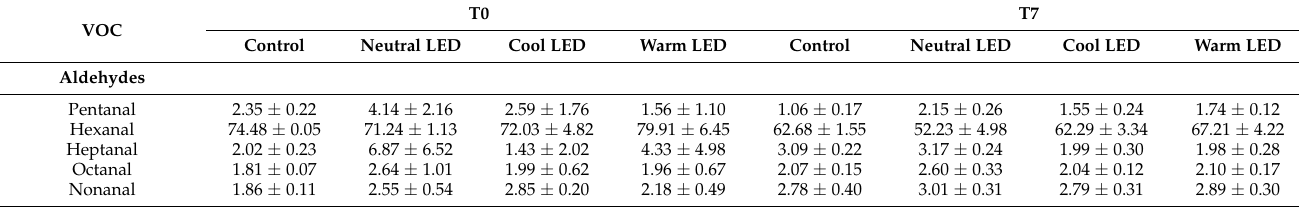
Table 4. Volatile profiles of cooked breast meat samples obtained from broilers exposed to different light treatments. VOC